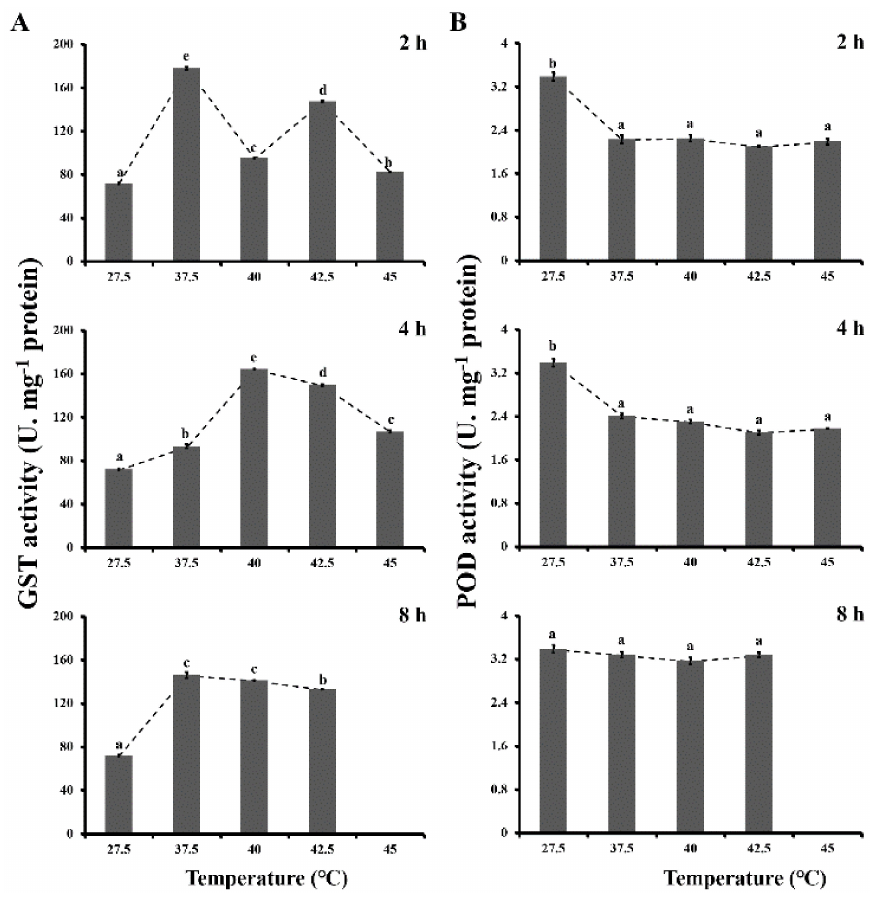
Figure 2. E ff ects of di ff erent thermal stresses on glutathione-S-transferases (GST) and peroxidases (POD) activities (U · mg − 1 protein) in Liposcelis bostrychophila . ( A ) GST activity. ( B ) POD activity. The temperature of 27.5 ◦ C served as a control. Each value represents the mean ( ± SE) of three replications. Di ff erent letters topped on the bar designated significant di ff erence at p < 0.05. No data was available at 45 ◦ C of 8 h exposure due to the death of tested